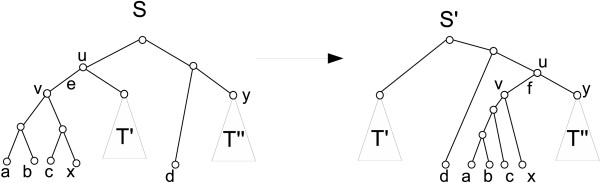
TBR Operation. Example depicting a TBR operation which transforms tree S into tree S' = TBRS(v, x, y).